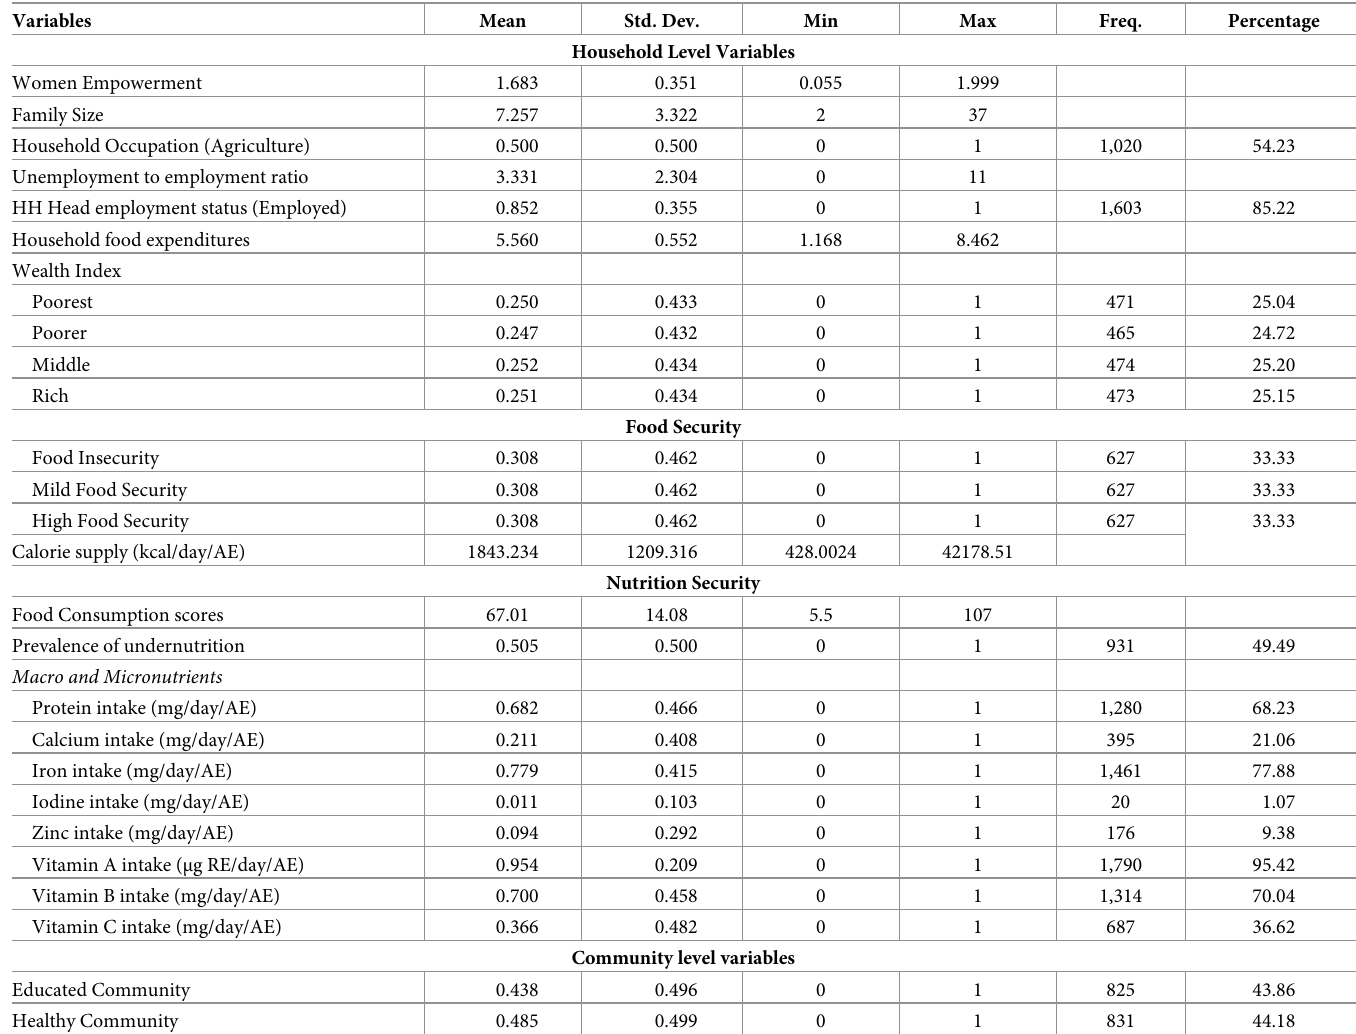
Table 1. Summary statistics of the sampled households (n = 1879) and communities (n =